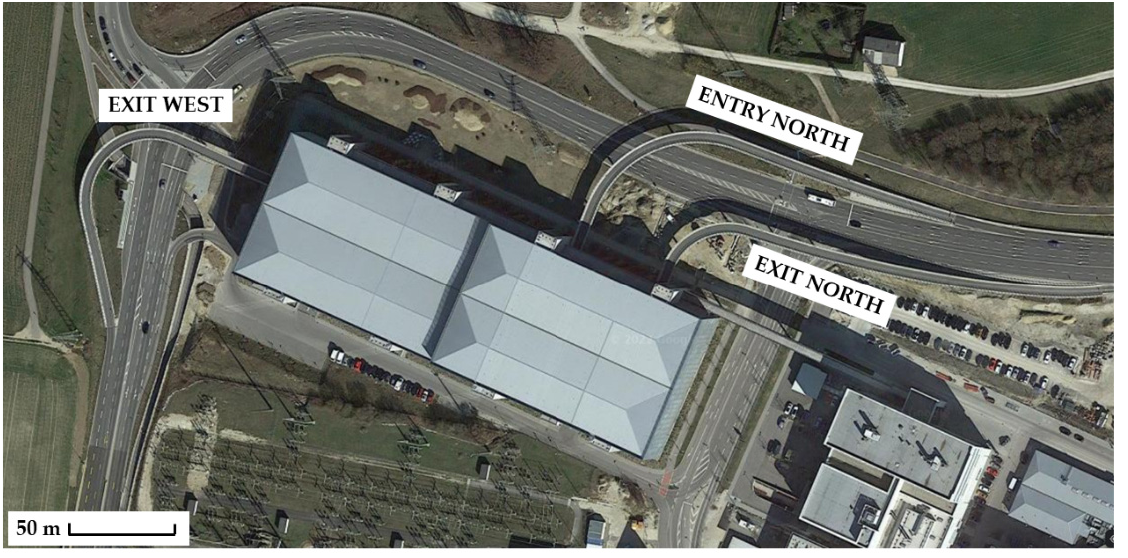
Figure 1. Aerial view of Ingolstadt HRS.